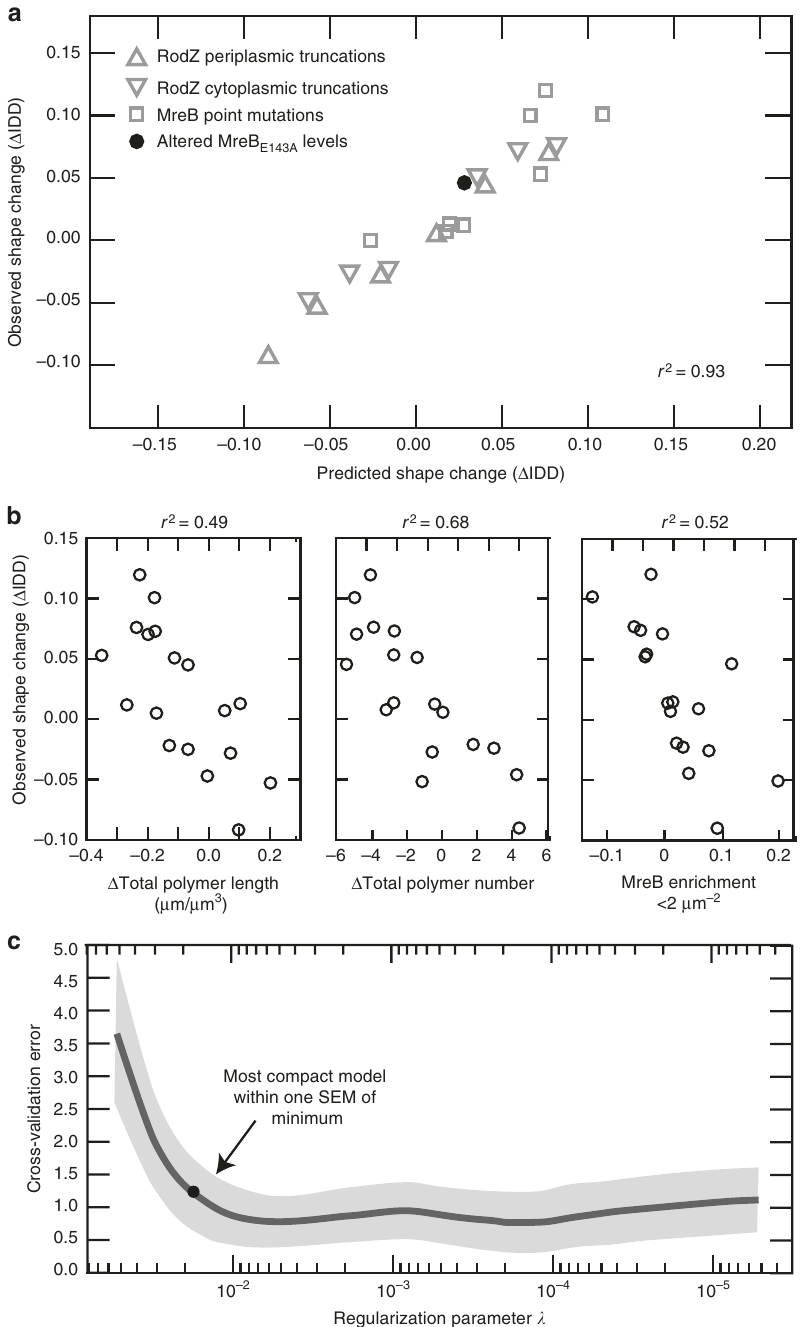
Fig. 4 LASSO analysis reveals that rod shape requires many long and geometrically-localized MreB polymers. a The correlation between observed and predicted cell shape when using the LASSO model combining parameters. See Table 1 for all the strains used and the observed and predicted IDD values. Note that to preserve its use as a test of the model, overexpression of MreB E143A was not used for model selection and training. r 2 value represents the square of the Pearson correlation coef fi cient. b Left — the correlation between observed and predicted cell shape when only using polymer length normalized by volume. Middle — the correlation between observed and predicted cell shape when only using polymer number. Right — the correlation between observed and predicted cell shape when only using average MreB enrichment at Gaussian curvatures below 2 μ m − 2 . c The mean squared error (MSE) of 10-fold cross-validation as a function of the LASSO regularization parameter. The solid curve is the mean MSE and the shaded region represents one standard error of the mean. The dot represents the most compact model within one standard error of the mean from the minimum of the curve. See Supplementary Table 2 for the coef fi cients in this